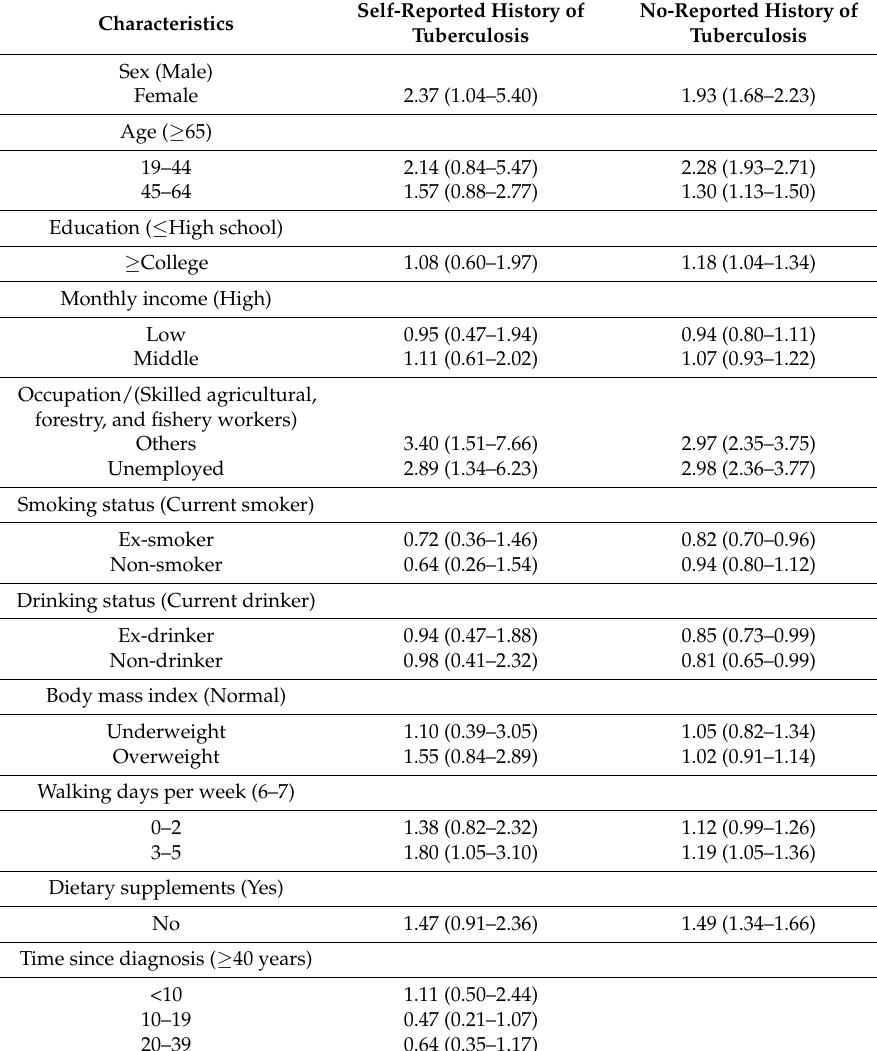
Table 3. Odds ratios (95% confidence interval) for vitamin D deficiency in the TB and control